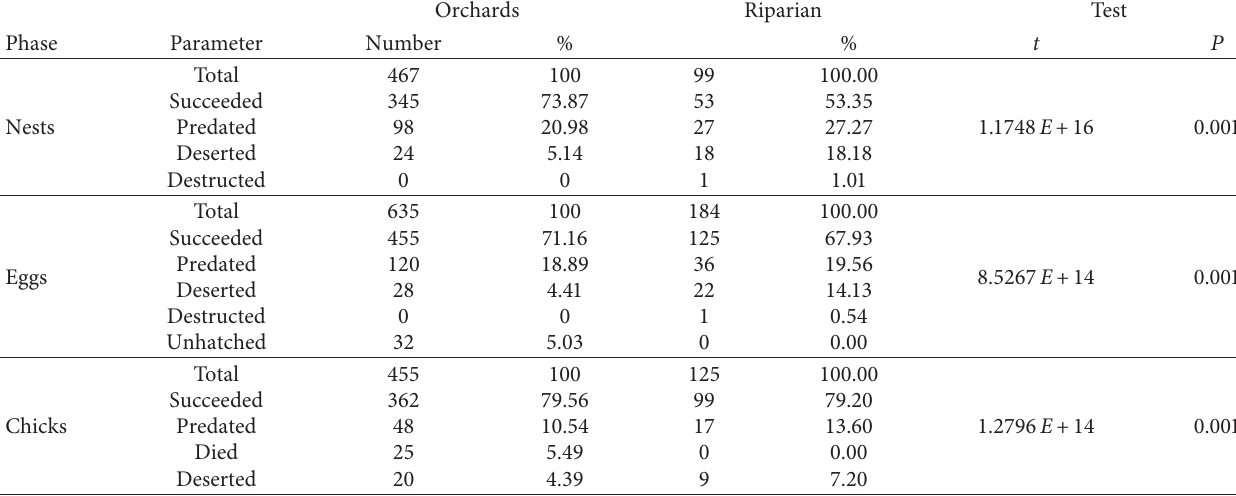
Table 3: Turtle dove’s breeding success at orchards ( n � 20 apple orchards) and riparian vegetation ( n � 18 riparian sites) tested with a simple t -test.